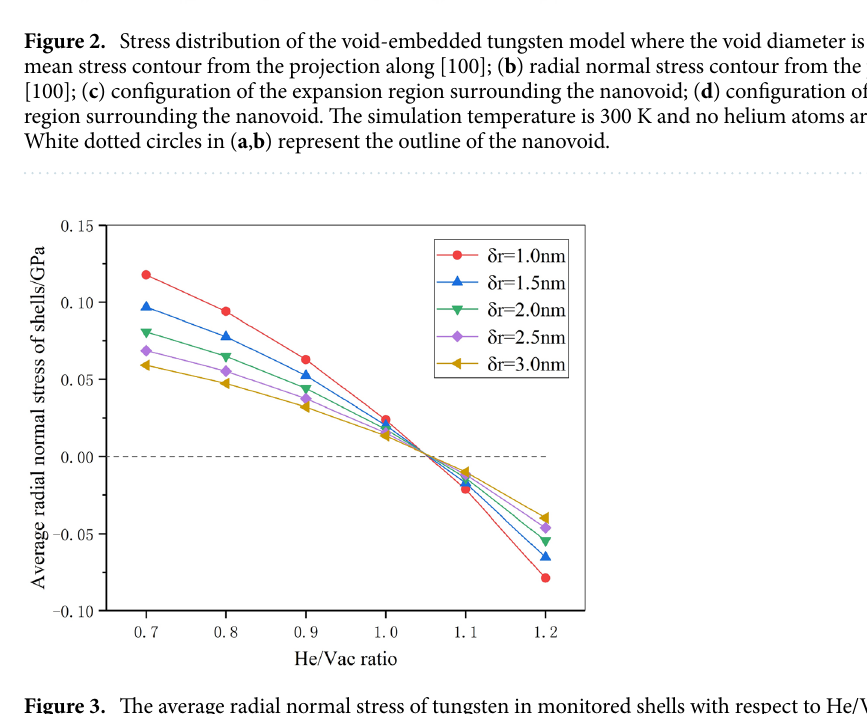
Figure 3. The average radial normal stress of tungsten in monitored shells with respect to He/Vac ratio regarding different shell